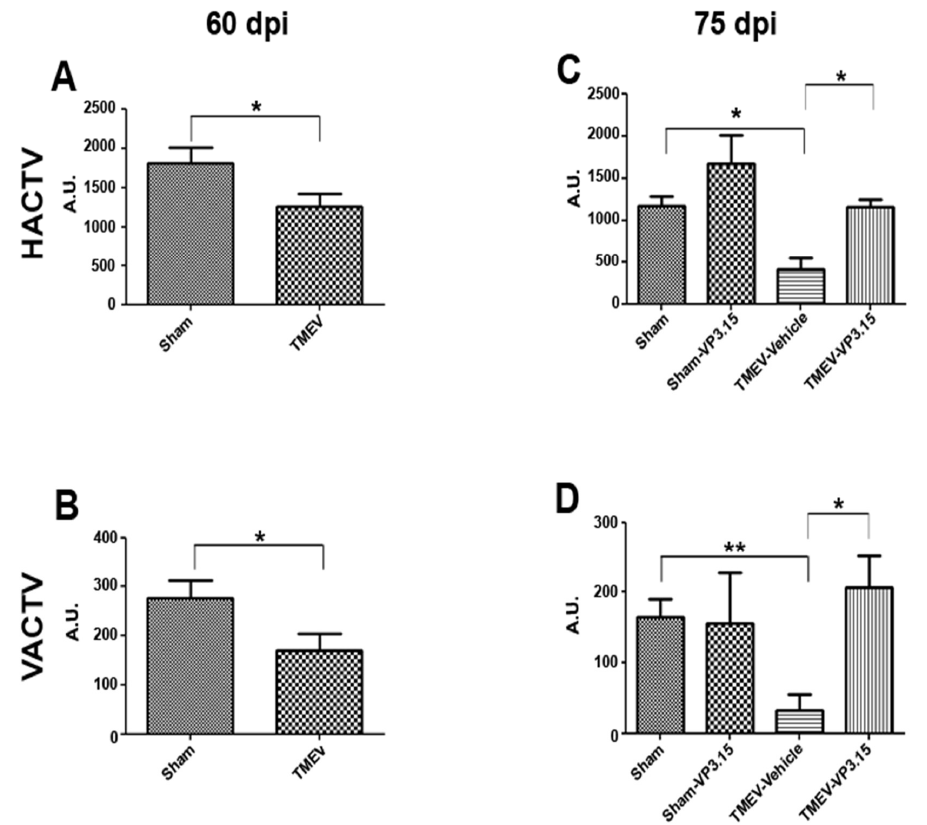
Figure 1. The treatment with VP3.15 delays TMEV-IDD progression. TMEV-infected mice were treated with VP3.15 (10 mg/kg) or appropriate vehicle at 60 days post infection for 15 consecutive days. The motor function was analyzed at days 60 ( A , B ) and 75 post infection ( C , D ) in an activity cage, including the horizontal activity (HACTV) and the vertical activity (VACTV) for 10 min. Student’s t -test ( A , B ): * p < 0.05; Sham vs. TMEV; ANOVA ( C , D ) * p < 0.05; ** p < 0.01 Sham-vehicle vs. TMEV-vehicle. The sample size was Sham = 11, TMEV = 14, Sham-Vehicle = 7, Sham-VP3.15 = 4, TMEV-Vehicle = 7, TMEV-VP3.15 =